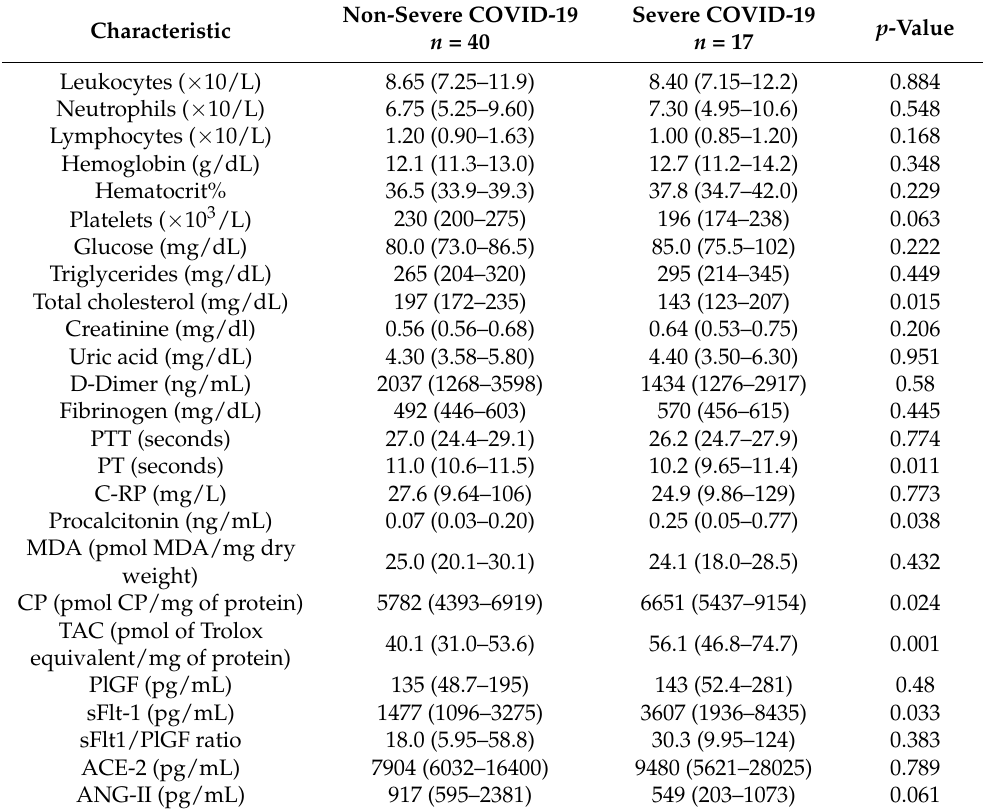
Table 2. Biochemical and hematological characteristics of pregnant women with